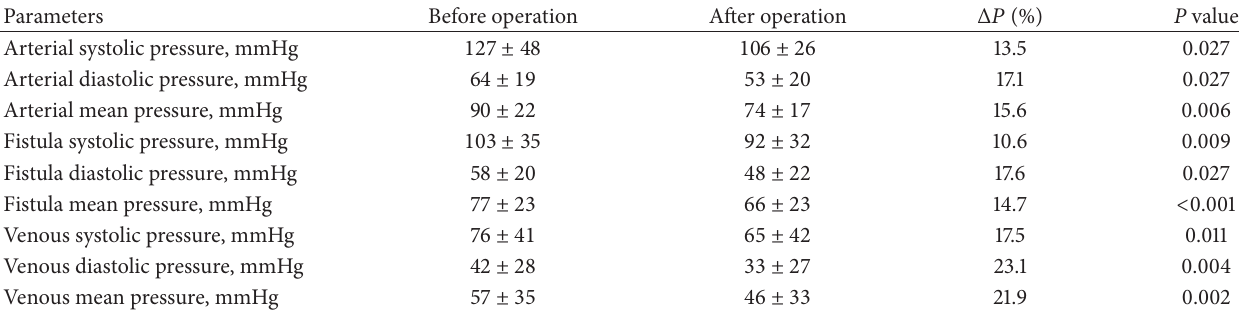
Table 2: Comparison of pressures in different localizations before and after operation.